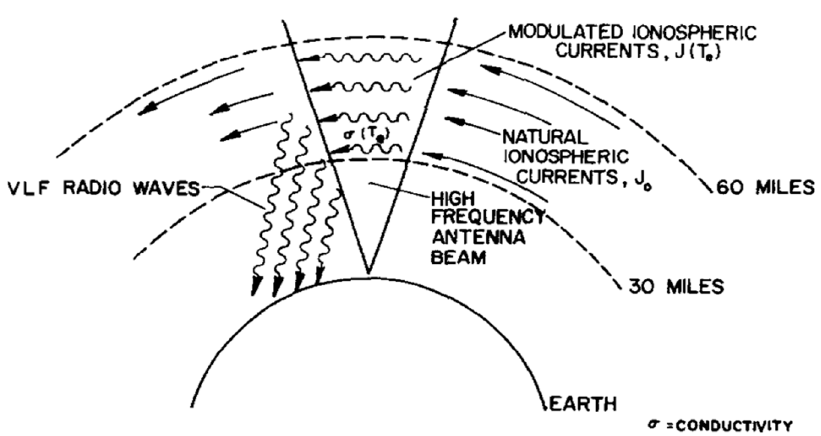
Figure 2. Schematic diagram of Amplitude Modulation (reprinted from Journal of Atmospheric and Terrestrial Physics, 44, Ferraro, A.J., Lee, H.S., Allshouse, R., Carroll, K., Tomko, A.A., kelly, F.J., Joiner,